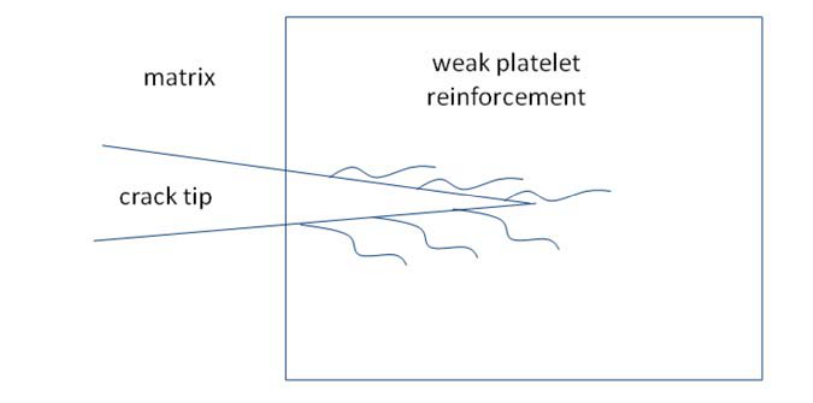
Figure 4. Interactions between a major crack and a weak